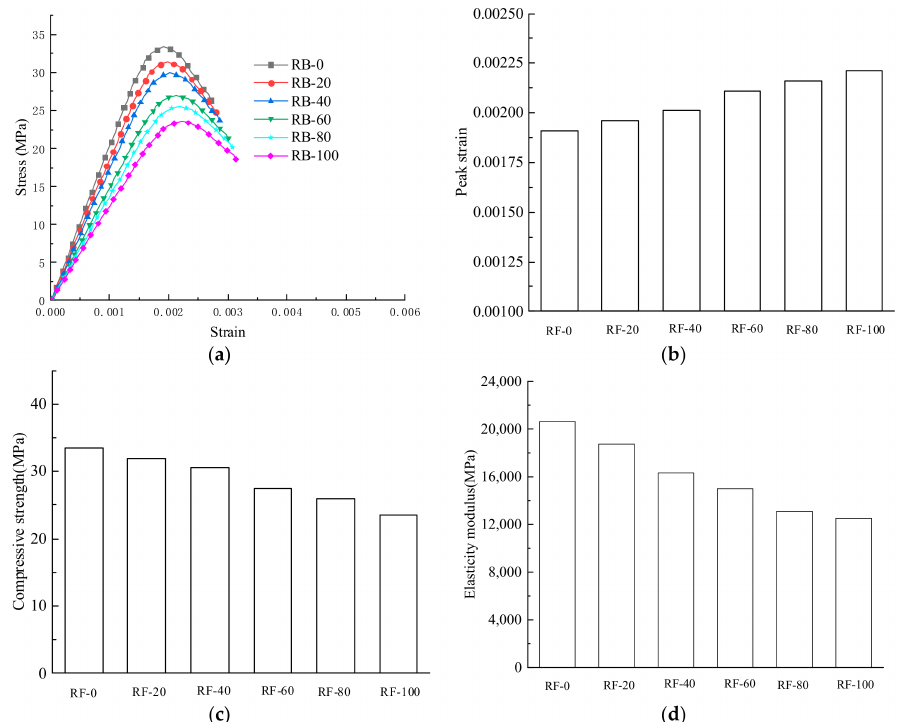
Figure 16. Finite element prediction results of concrete with different RBCA content: ( a ) stress–strain curve, ( b ) histogram of peak strain, ( c ) histogram of compressive strength, ( d ) histogram of elasticity